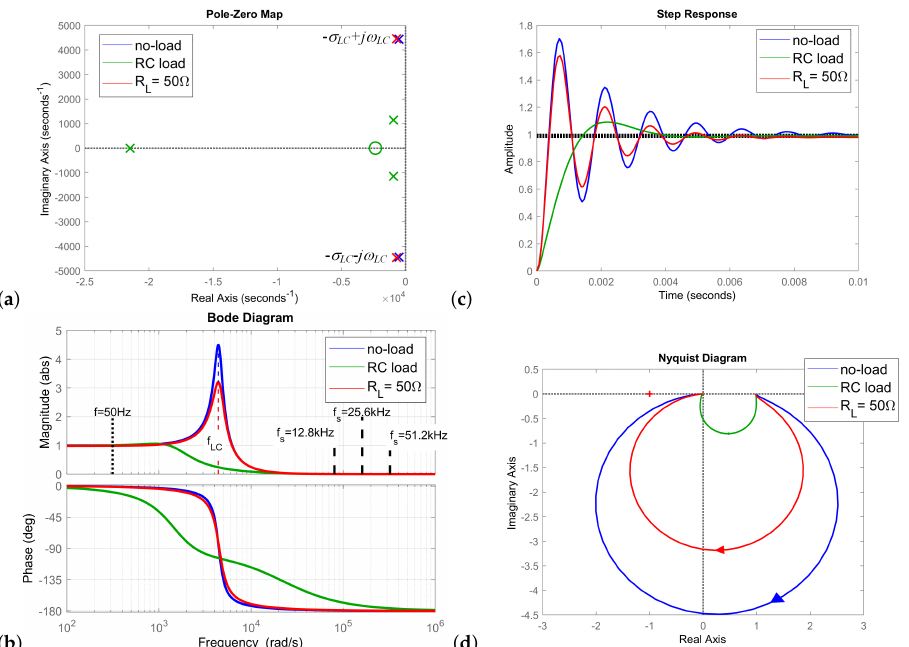
Figure 5. ( a ) Poles and zero, ( b ) step responses, ( c ) Bode, and ( d ) Nyquist plots of the open-loop system in two modes. Blue lines—idle, green lines—activ load. In the no-load mode there is σ LC = 500, ω LC = 4444. The resonant frequencies f LC are 702.8 Hz for R L = ∞ , and 701.4 Hz for R L = 50. Note small differences between characteristics of the no-load and the resistive load system, and a large discrepancy between the no-load and RC load